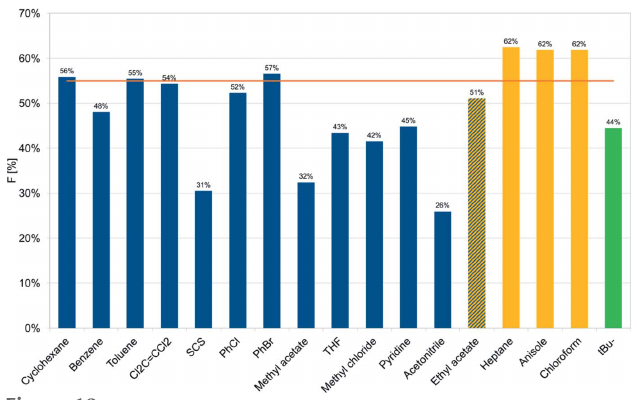
Figure 12 Fill percentages ( F ) for the various guest molecules (for the major component if disorder is present in the crystal structure). Blue denotes guest molecules that form inclusion complexes, yellow denotes guests that form exclusion complexes and cross-hatching indicates ethyl acetate from which the unsolved crystal structure is obtained. Green represents the volume of the t Bu group. The orange line corresponds to F = 55%.